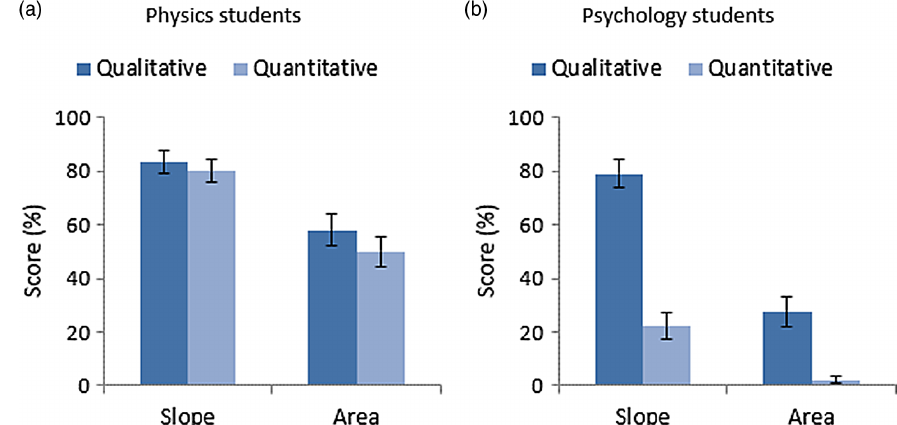
FIG. 2. (a) Average scores of physics students on the qualitative and quantitative questions about graph slope and area under a graph. (b) Average scores of psychology students on the qualitative and quantitative questions about graph slope and area under a graph. The error bars represent 1 standard error of the mean (SEM).